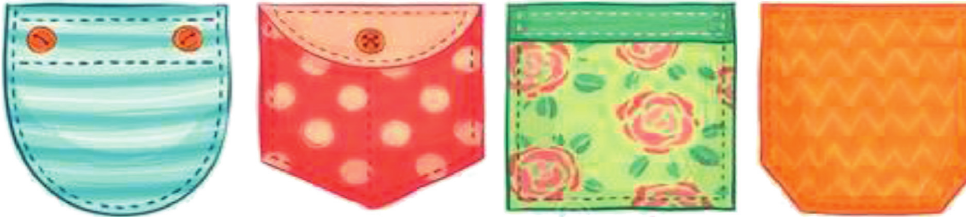
Figure 5: Animation types of clothes pockets made of different fabrics (http://alturl.com/qb5jb).